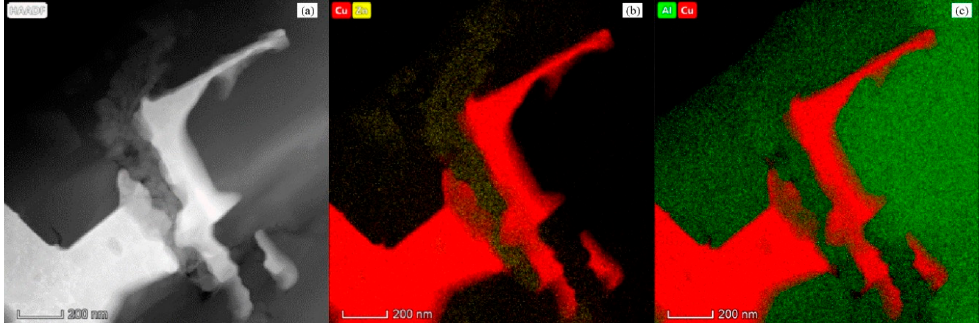
Figure 9. Element distributions of Al 2 O 3 /30glass/30Cu f substrate: ( a ) HAADF-STEM micrograph; ( b ) Distribution of Cu and Zn elements marked by red and yellow, respectively; ( c ) Distribution of Cu and Al elements marked by red and green, respectively.